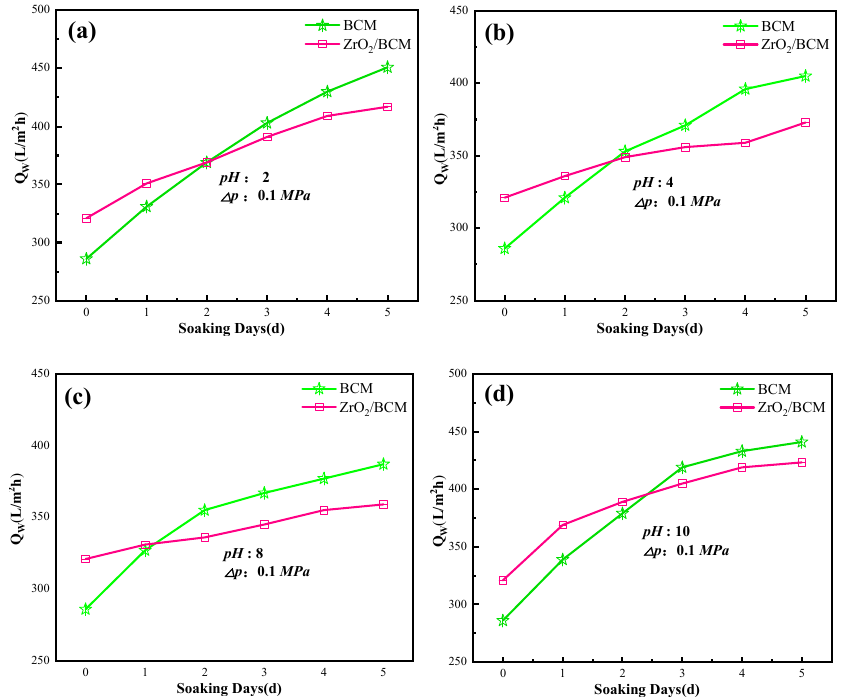
Figure 11. The influence of pH on the membrane fluxes of BCM and 1 wt.% ZrO 2 /BCM. The test conditions ( a – d ) of the membrane are respectively: pH 2, 4, 8, 10.